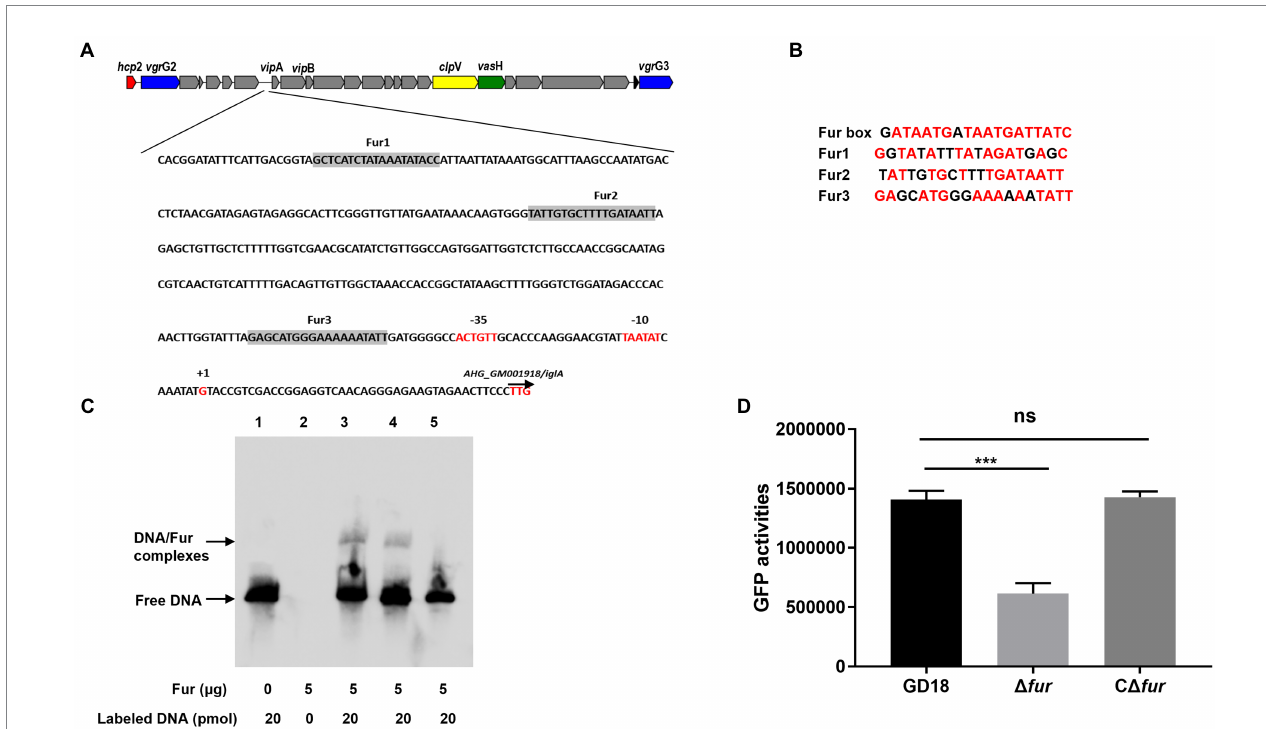
FIGURE 3 Fur protein binds directly to the promoter region of vip A in the T6SS gene cluster. (A) In silico analysis for Fur binding box prediction in the T6SS gene cluster. The putative Fur binding boxes are indicated as gray boxes. The transcriptional initiation site, the corresponding 10 and 35 boxes, and the translational start site are indicated in red letters. (B) Sequence alignment of these putative Fur binding boxes with the Fur box consensus sequence. Bases identical to the consensus are shown in red. (C) The different DNA fragments of vip A promoter region were amplified, biotin labeled, and used as probes. EMSA of Fur protein (5 μ g) and biotin-labeled probes was performed. Line 1: DNA probes control; line 2: Negative control; line 3: Fur1; line 4: Fur2; line 5: Fur 3. (D) The GFP activities of the P vipA - gfp reporter fusions were measured in the WT and Δ fur strains. The error bars represent mean ± standard deviations from three independent experiments (*** p < 0.001; ns, no